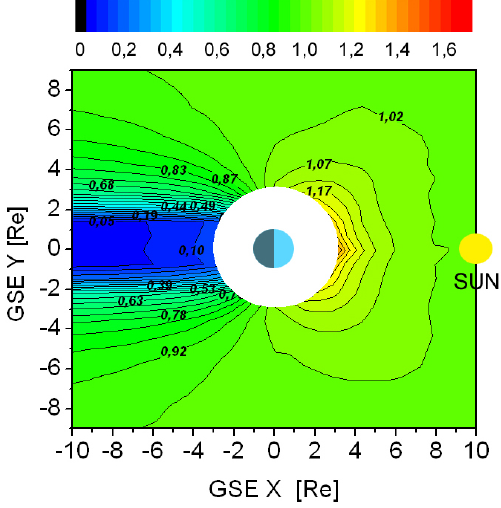
Figure 1. Ratio (cid:15)(r,θ,φ) of the local Lyman- α illumination (influ- enced by multiple-scattering effects) and the original solar illumina- tion within the ecliptic plane calculated with a multiple-scattering Monte Carlo model. The exospheric density used in the MCM is taken from Zoennchen et al. (2013). Far from the Earth–Sun line, the exosphere is optically thin for solar Lyman- α